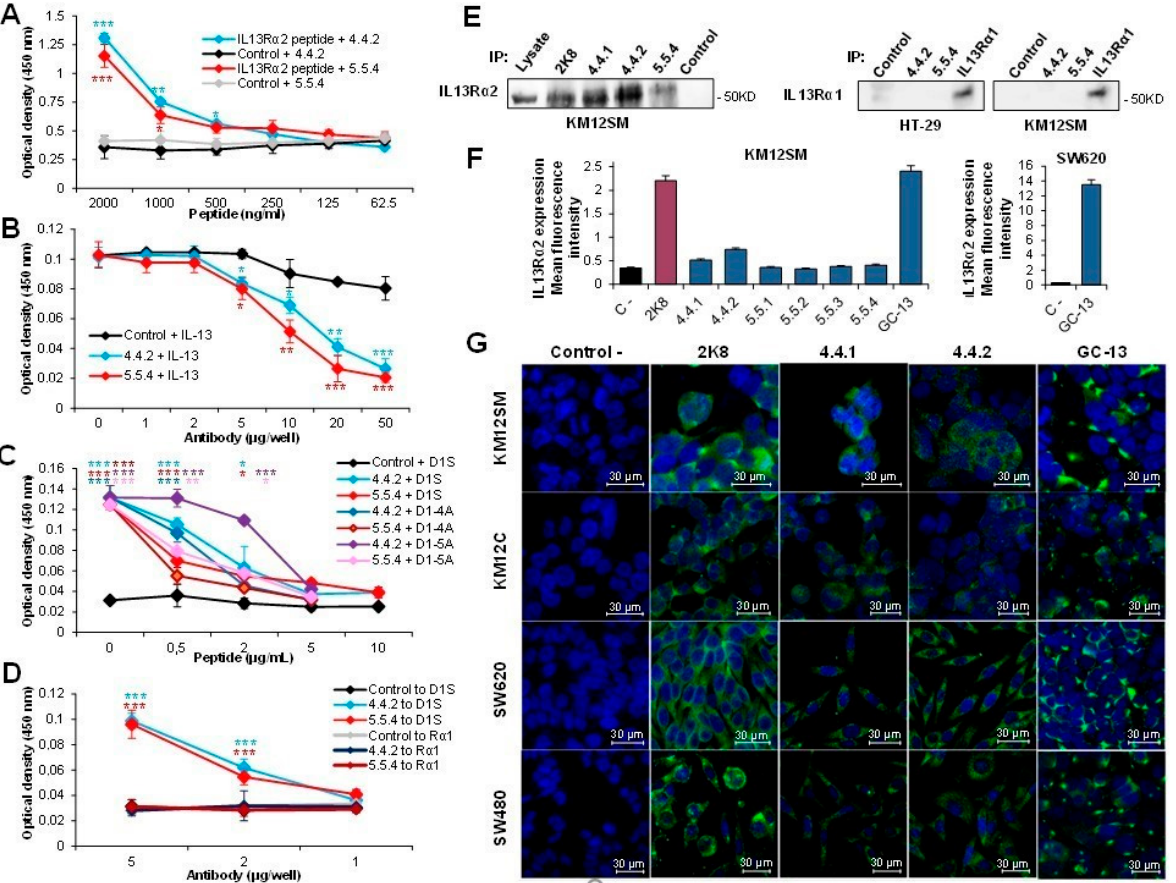
Figure 2. Functional characterization of anti-IL13R α 2 D1 peptide antibodies. ( A ) Capture ELISA of IL13R α 2 D1 biotin-labelled peptide or an irrelevant biotin-labelled peptide using immobilized anti-IL13R α 2 mAbs 4.4.2 or 5.5.4. Quantification of bound peptide was performed by streptavidin-HRP. MAbs 4.4.2 and 5.5.4 significantly bound to IL13R α 2-derived peptide compared to an irrelevant peptide (* p < 0.05; ** p < 0.01; *** p < 0.001). ( B ) MAbs 4.4.2 or 5.5.4 significantly inhibited the binding of IL-13 to immobilized IL13R α 2 using a competition ELISA (* p < 0.05; ** p < 0.01; *** p < 0.001). ( C ) IL13R α 2-derived peptides (D1S and alanine variant forms of D1) inhibited the binding of mAbs 4.4.2 or 5.5.4 to immobilized IL13R α 2 using a competition ELISA. MAbs 4.4.2 or 5.5.4 significantly bound to IL13R α 2 compared to an irrelevant antibody (* p < 0.05; ** p < 0.01; *** p < 0.001). ( D ) MAbs 4.4.2 or 5.5.4 significantly bound to IL13R α 2-derived peptide (D1S) compared to IL13R α 1-derived peptide (* p < 0.05; ** p < 0.01; *** p < 0.001). ( E ) IL13R α 2 immunoprecipitation using IL13R α 2 D1 mAbs in KM12SM cells (2K8, commercial IL13R α 2 Ab, Ctrl: Negative control). As positive control a lane with 100 µ g of whole cell lysate of KM12SM cell was added to the blot. The indicated antibodies were also tested for immunoprecipitation of IL13R α 1 in HT-29 and KM12SM extracts. Only commercial anti-IL13R α 1 was able to immunoprecipitate this receptor. ( F ) Flow cytometry using IL13R α 2 D1 mAbs. ( G ) Immunofluorescence analysis of IL13R α 2 expression and staining using IL13R α 2 D1-specific mAbs in KM12SM, KM12C, SW620 and SW480 colorectal cancer cells. Scale bar: 30 µ